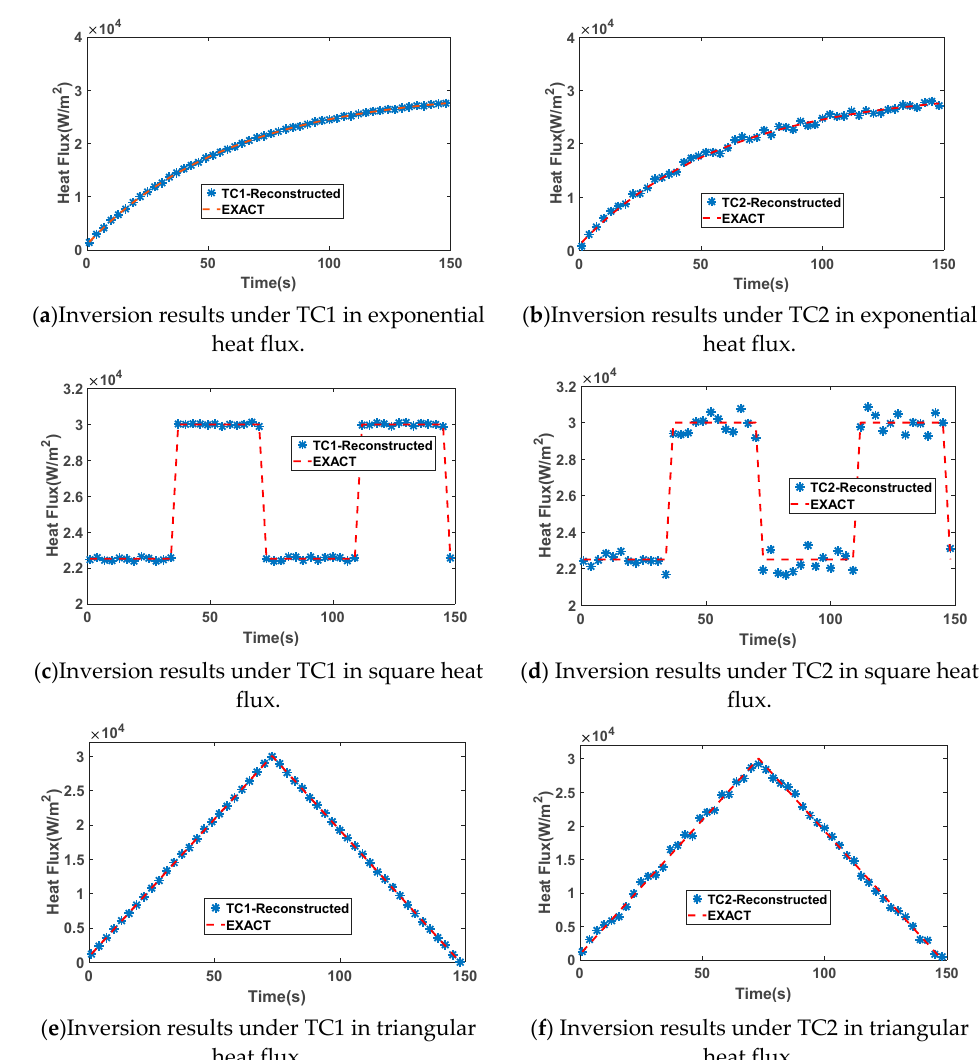
Figure 6. Influence of the location of the measurement points on the inversion results under three different types of heat flux. ( a , c , e ) are inversion heat fluxes under temperature measurement point TC1, ( b , d , f ) are inversion heat fluxes under temperature measurement point TC2. Table 3. Inversion error under three different types of heat flow.